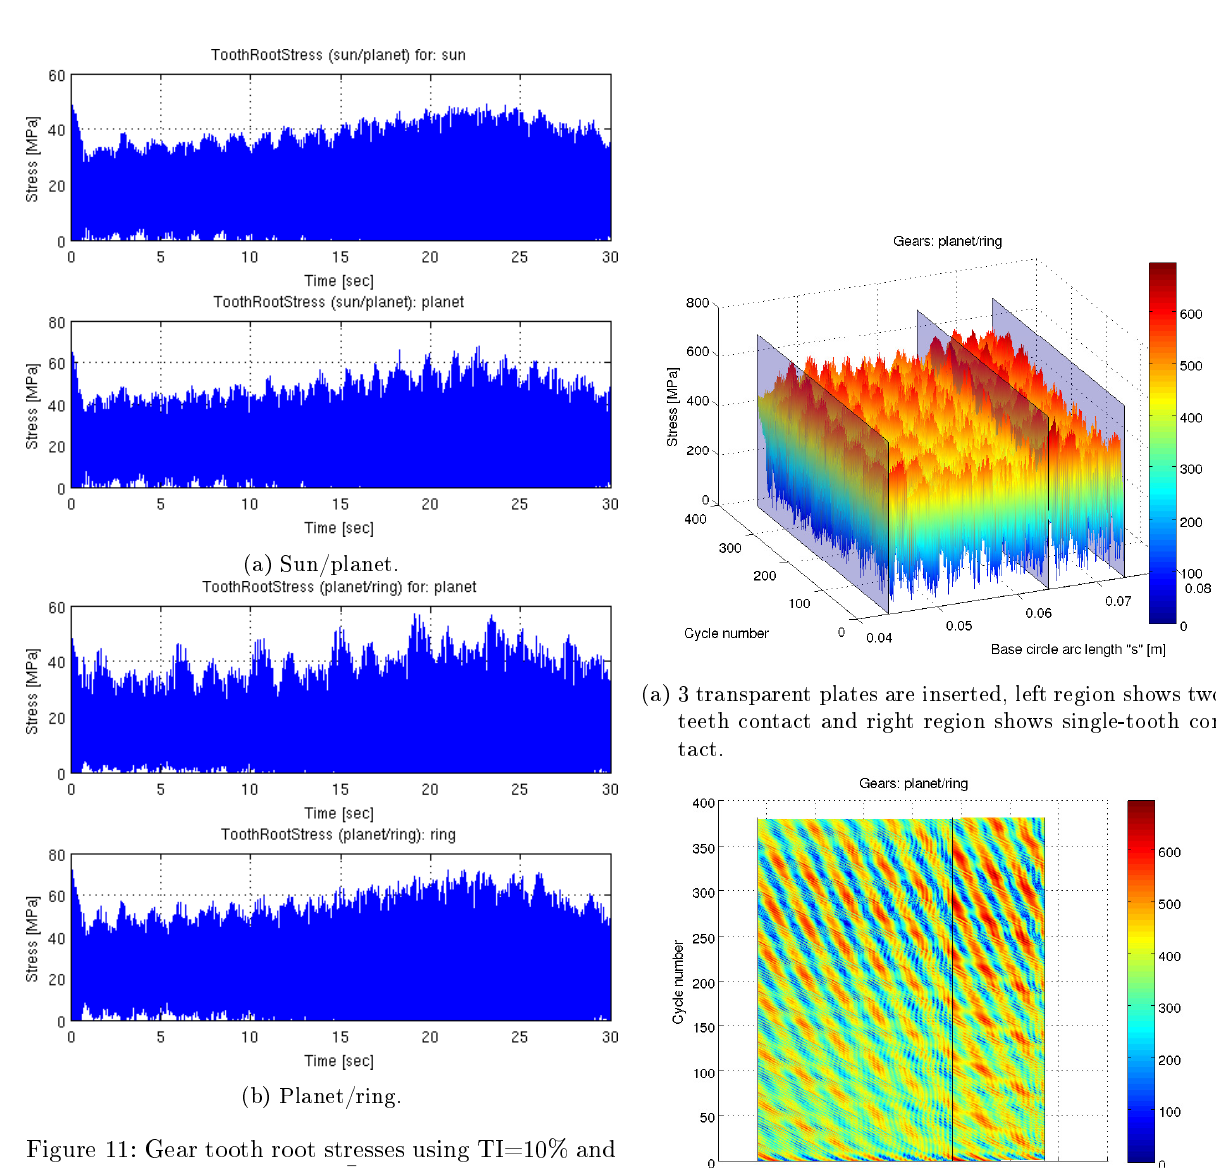
Figure 11: Gear tooth root stresses using TI=10% and mean wind speed ¯ U = 20 m/s.